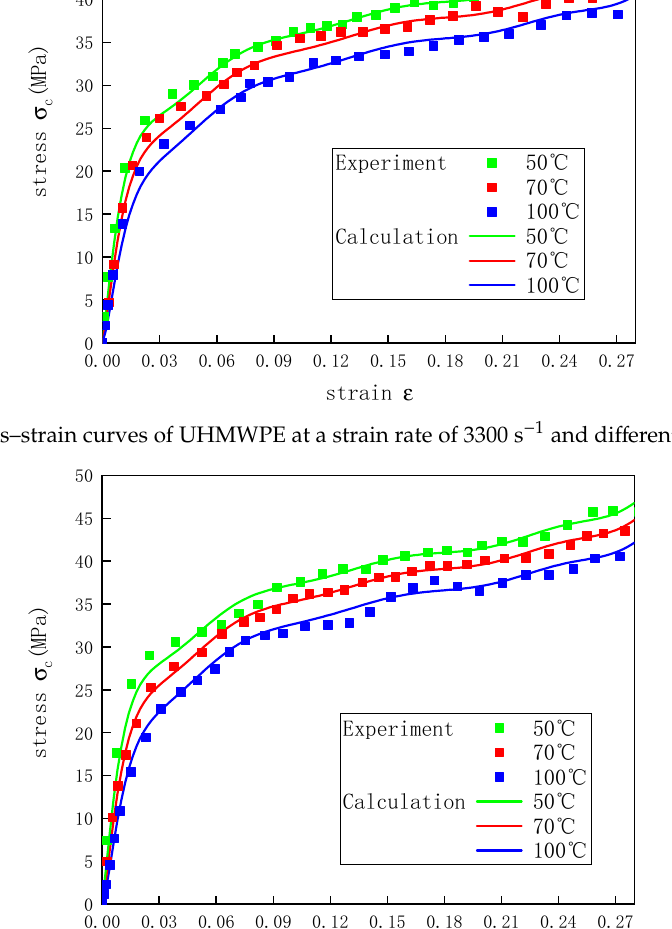
Figure 15. Stress–strain curves of UHMWPE at a strain rate of 4300 s − 1 and different temperatures.